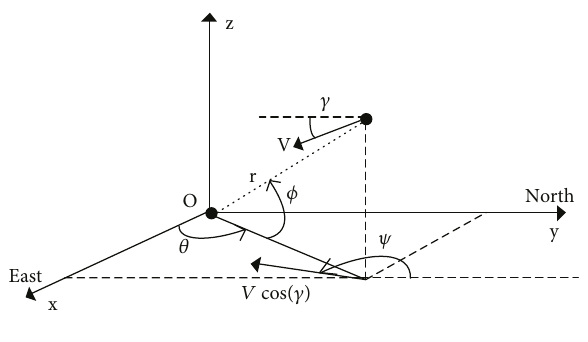
Figure 1: Coordinate system and related